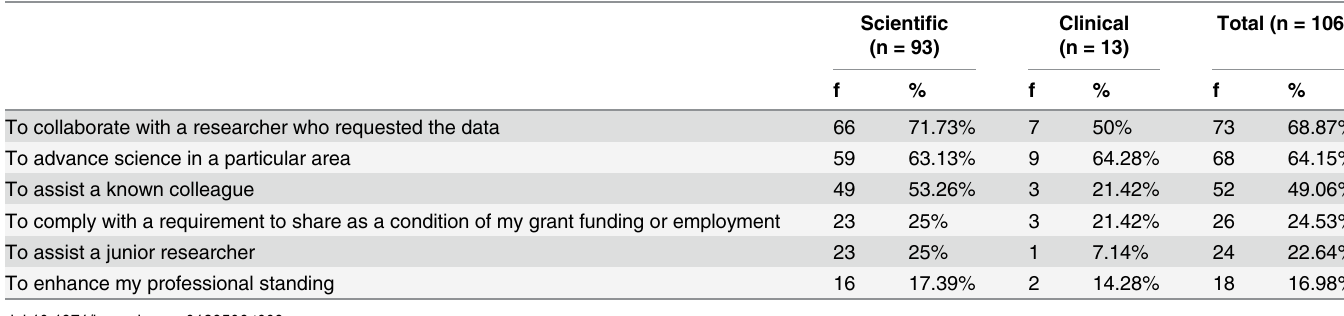
Table 9. Responses to “ What was your motivation for sharing your data? Please check all that apply.